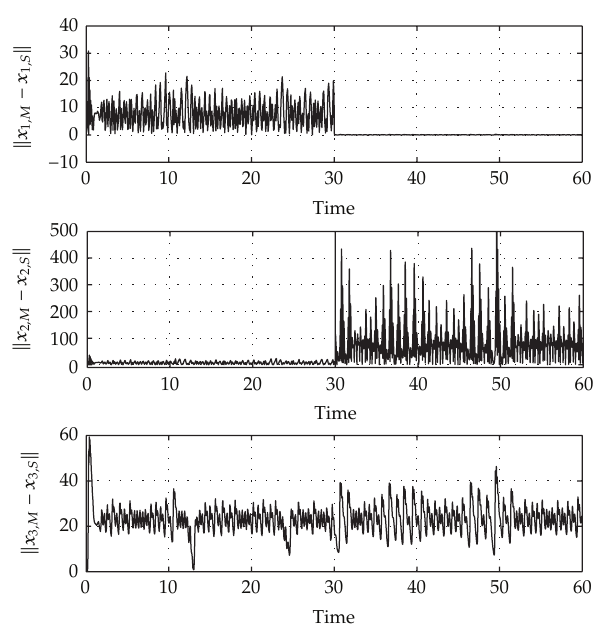
Figure 1: Synchronization errors between system states, only the output states (cid:3) x 1 ,M ,x 1 ,S (cid:4) are synchronous.